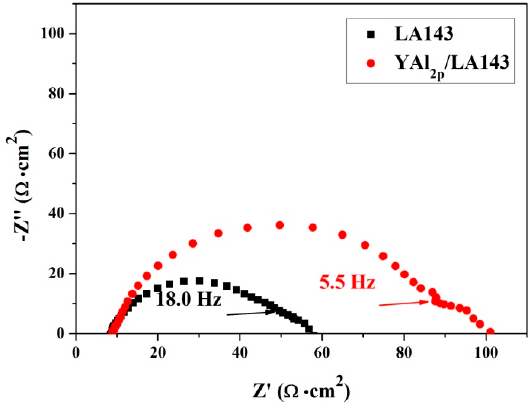
Figure 9. Nyquist plots of LA143 and YAl 2p /LA143 in 3.5% NaCl solution.